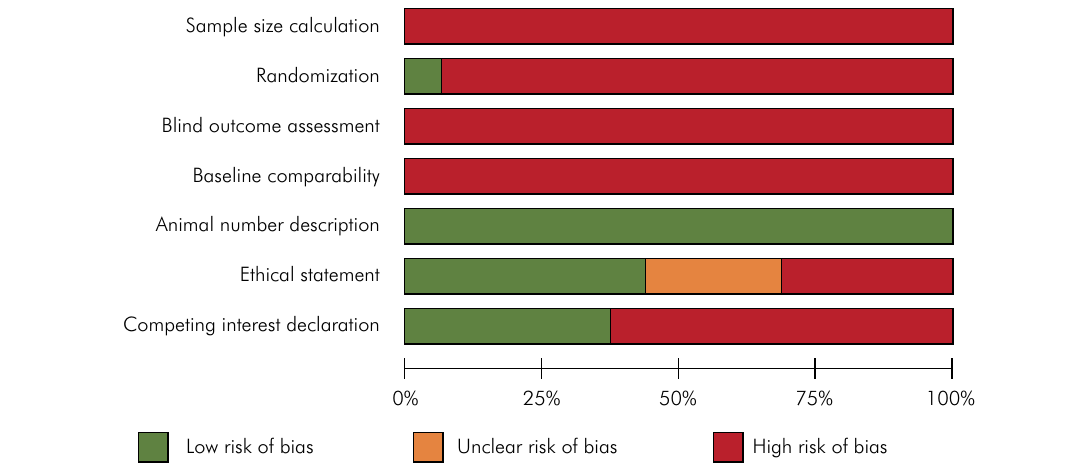
Figure 2. Judgements about each risk of bias item presented as percentages across all included studies.